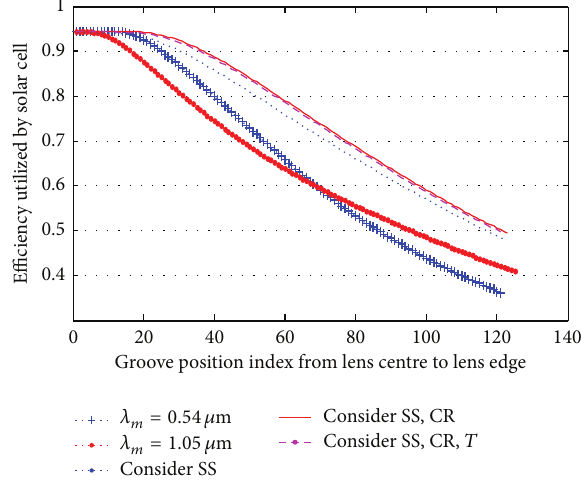
Figure 10: The different design main wavelength of each groove for the conventional design and the novel design (SS: solar spectrum; CR: cell response; T : temperature). Figure 11: The energy efficiency of each groove for the conventional